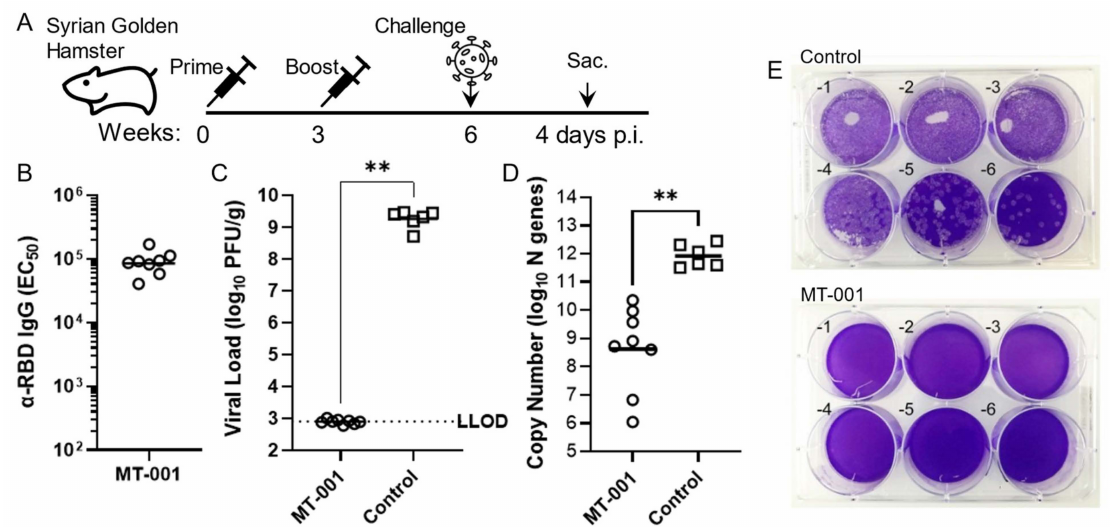
Figure 4. SARS-CoV-2 challenge of hamsters vaccinated with MT-001 adjuvanted with Alhydrogel and CpG ODN1826. ( A ) MT-001 prime-boost regimen and SARS-CoV-2 challenge schedule for Syrian golden hamsters. ( B ) Midpoint hamster RBD-specific IgG ELISA GMTs. ( C ) Lung viral load in hamsters vaccinated with 10 µ g of MT-001 co-adjuvanted with 500 µ g Alhydrogel + 100 µ g CpG ODN1826, or mock-vaccinated with adjuvants alone, and infected with 10 5 PFU of SARS-CoV-2 six weeks after the primary immunization (top). Individual data points and mean +/ − S.D for MT-001 with adjuvants (open circles; n = 8) or adjuvants alone (open squares; n = 6) is shown. ( D ) Viral